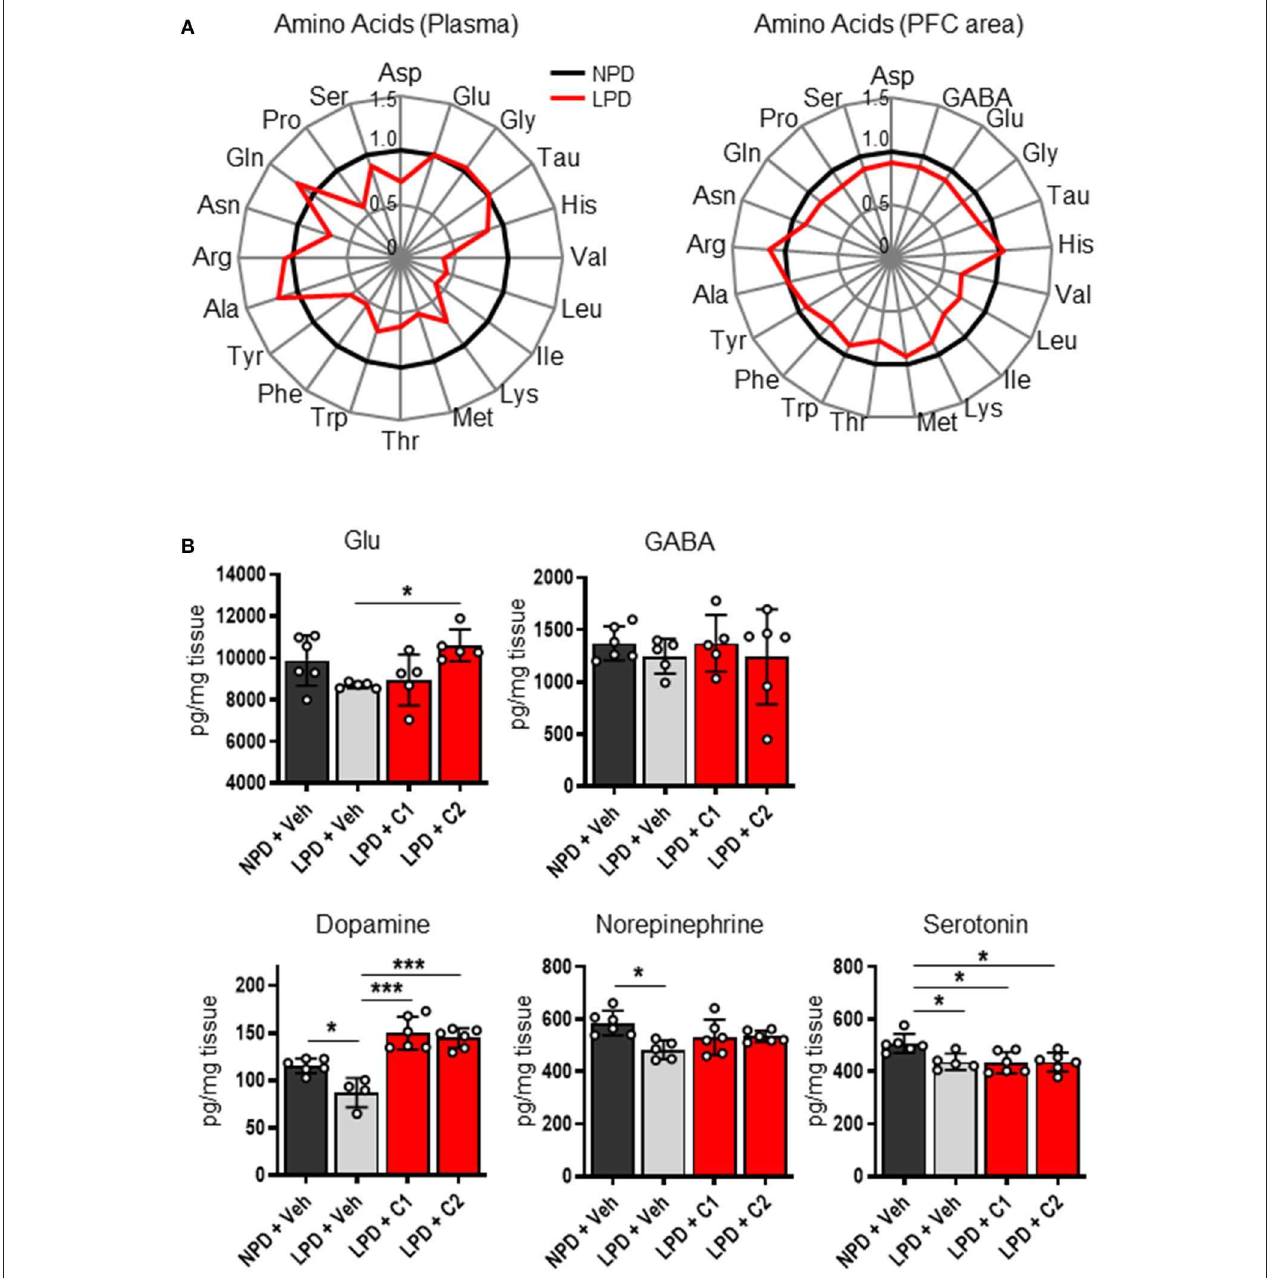
FIGURE 2 | The concentrations of amino acids and neurotransmitters in the plasma and brain were decreased by LPD. (A) Radar charts of amino acids in aged B6 mice. The average of each amino acid concentration as normalized values in the plasma (left) and prefrontal cortex area (PFC area; right) are expressed. (B) Mean neurotransmitter concentrations in the PFC area after sacrifice in each group. The Glu concentration [F (3,17) = 4.2, p < 0.05] was significantly lower in the LPD + C2 group than in the LPD + Veh group (* p < 0.05). The dopamine concentration [F (3,18) = 23.9, p < 0.001] was significantly lower in the LPD + Veh group than in the NPD + Veh group (* p < 0.05), in the LPD + Veh group than in the LPD + C1 group (*** p < 0.001), and in the LPD + Veh group than in the LPD + C2 group (*** p < 0.001). The norepinephrine concentration [F (3,19) = 4.5, p < 0.05] was significantly lower in the LPD + Veh group than in the NPD + Veh group (* p < 0.05). The serotonin concentration [F (3,19) = 5.7, p < 0.01] was significantly lower in the LPD + Veh group than in the NPD + Veh group (* p < 0.05), in the LPD + C1 group than in the NPD + Veh group (* p < 0.05), and in the LPD + C2 group than in the NPD + Veh group (* p < 0.05). Error bars and dots indicate SD and scores of individual mice,